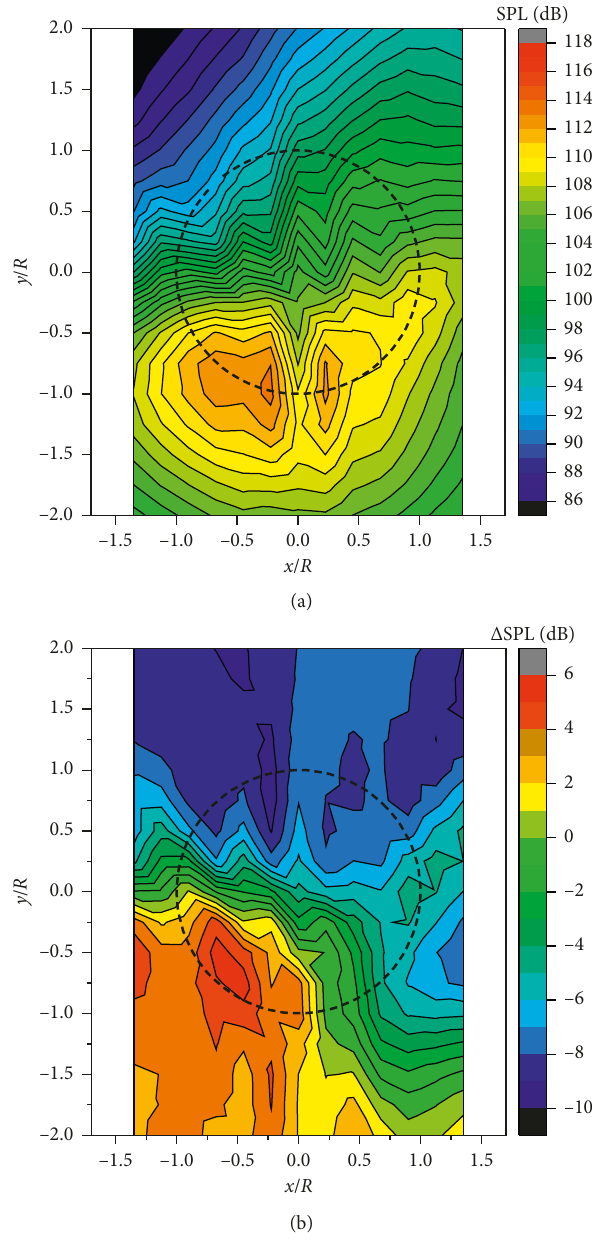
Figure 11: Midfrequency (6th–40th) BVI noise directivity pattern of the ECR with 4 ∘ pre-index angle. (a) Predicted SPL noise contours; (b) difference of SPL between ECR with 4 ∘ and 6 ∘ pre- index